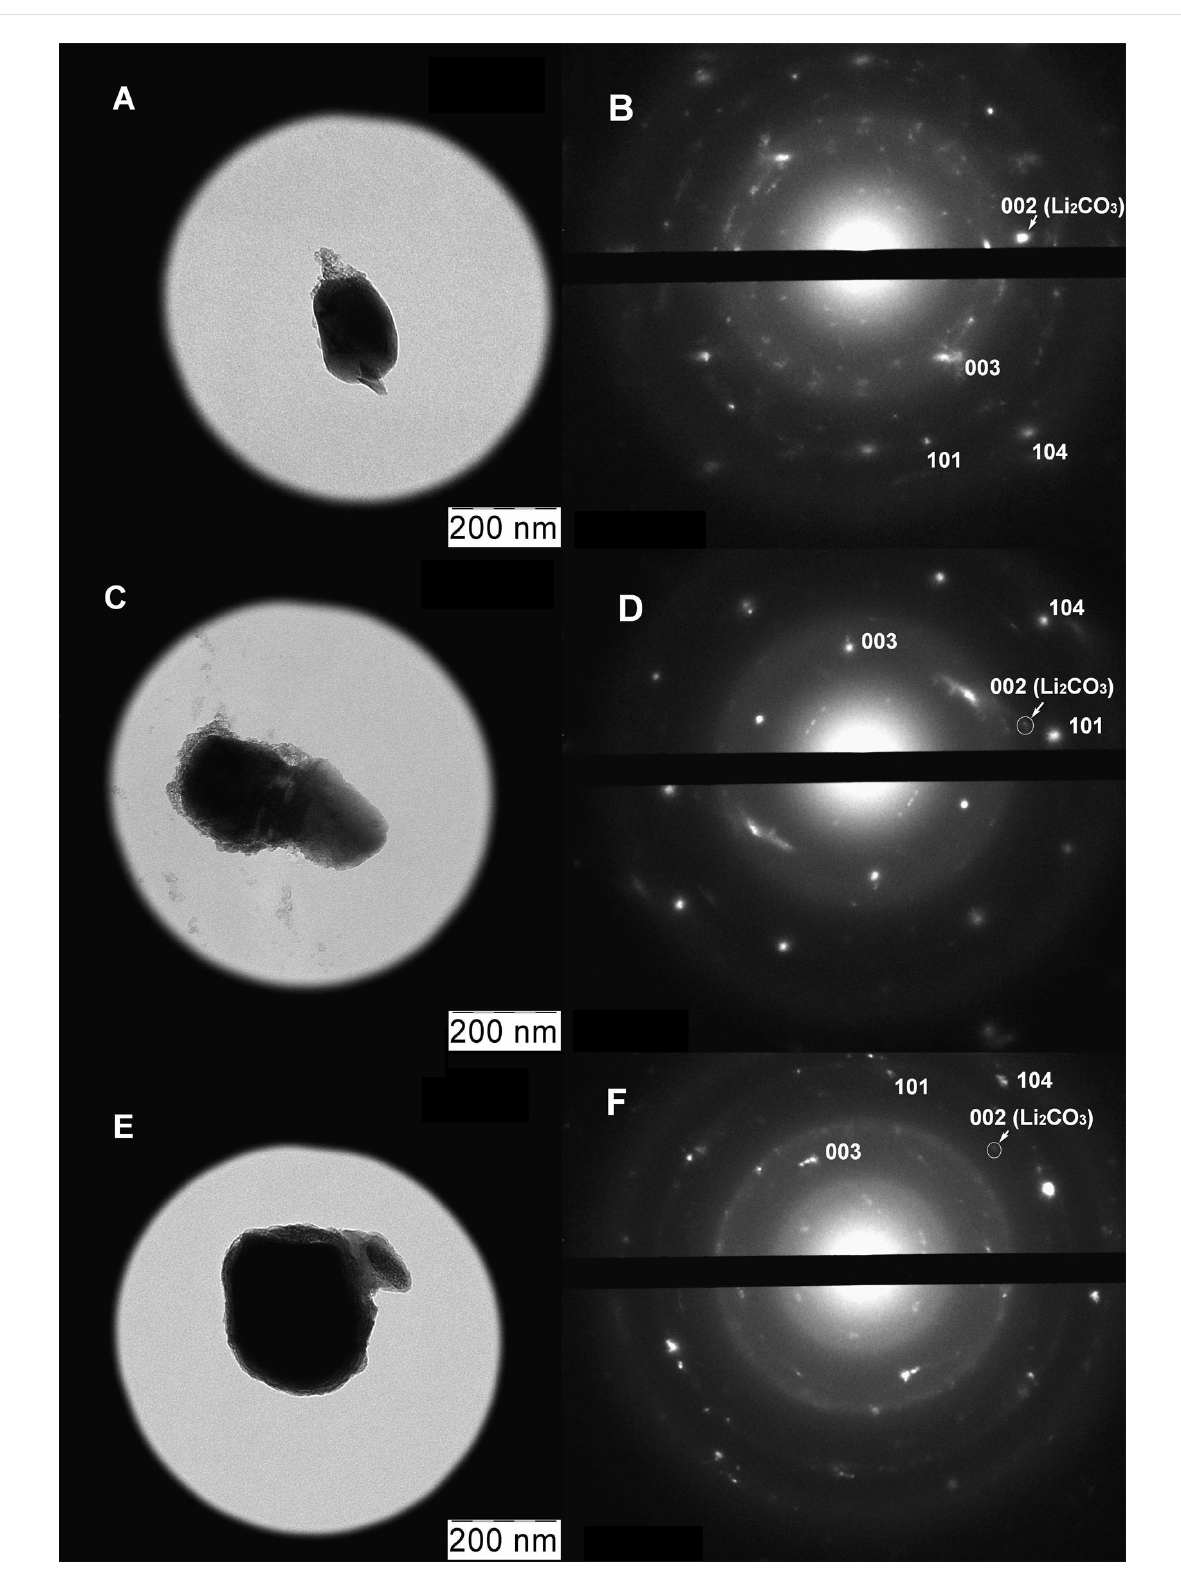
Figure 9: TEM micrographs and SAED patterns of the cycled electrode materials based on Li 1.4 Ni 0.5 Mn 0.5 O 2+ x (A,B) and LNM/C nanocomposites ob- tained by the pyrolysis of linear (C,D) and cross-linked (E,F) PVA. The cycling conditions are shown in Figure